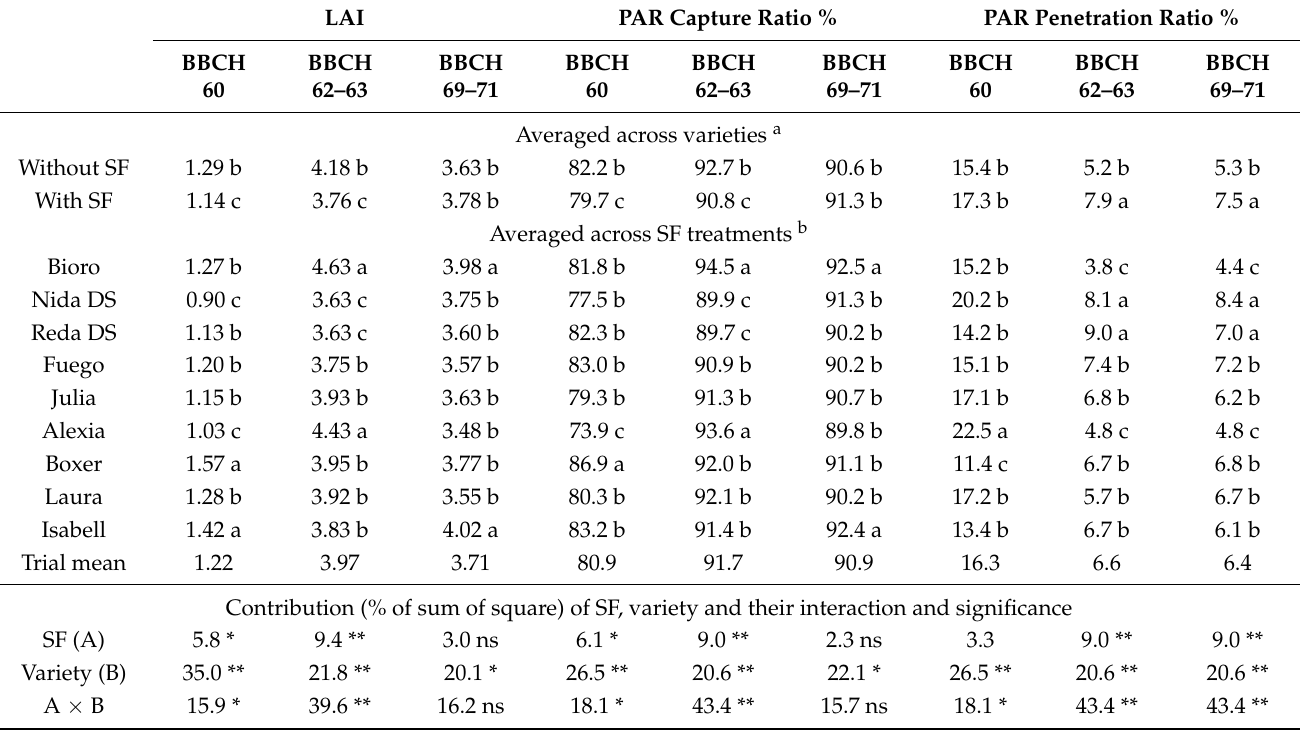
Table 4. The influence of seed fungicide (SF) and variety on leaf area index (LAI) and photosynthetic active radiation (PAR) capture ratio and penetration ratio in the canopy of faba bean in the second